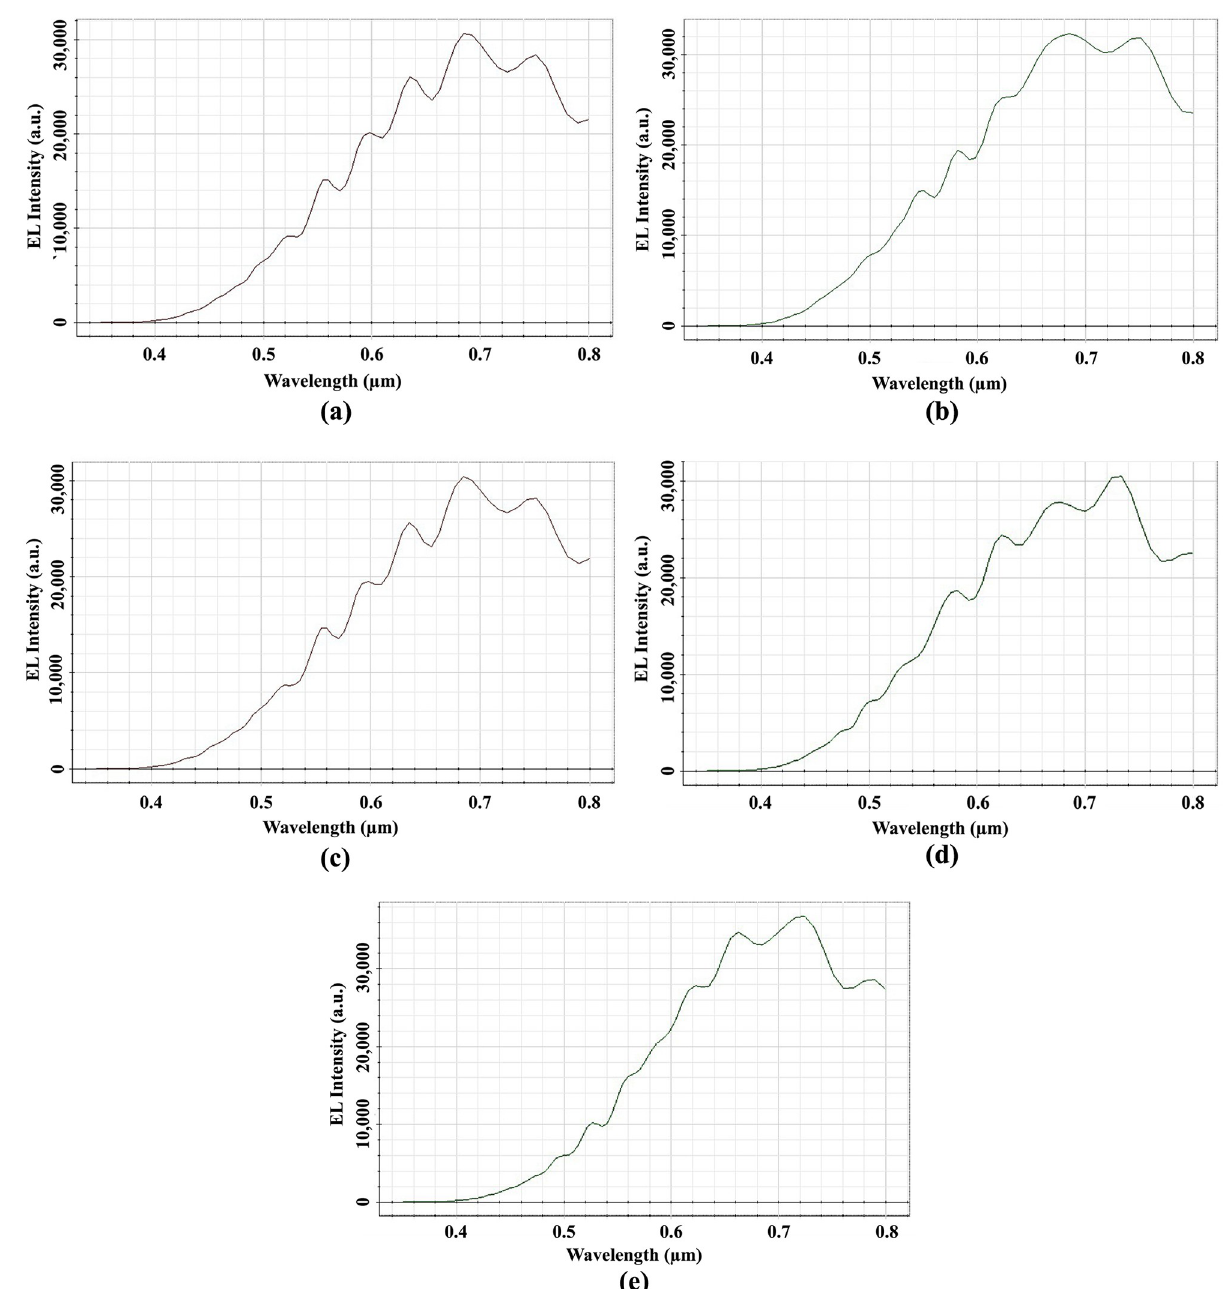
Fig 17. EL Intensity of Ey for elliptical planoconcave MLA engraved OLEDs: (a) Concave-1; (b) Concave-2; (c) Concave-3; (d) Concave-4; (e) Concave-5. https://doi.org/10.1371/journal.pone.0269134.g017 16.80% and 16.14% for the ERI of 1.82, 1.79, 1.725 and 1.76, respectively. Consequently, high- est EQE was obtained for Spherical-7 (0.6 μ m radius/height) MLA engraved OLED among all the spherical planoconcave MLA engraved OLEDs. In addition, spherical planoconcave (Spherical-7) MLA engraved OLED achieved the better EQE compared to spherical planocon- vex MLA engraved OLEDs. Additionally, 0.6 μ m radius/height can be considered as the